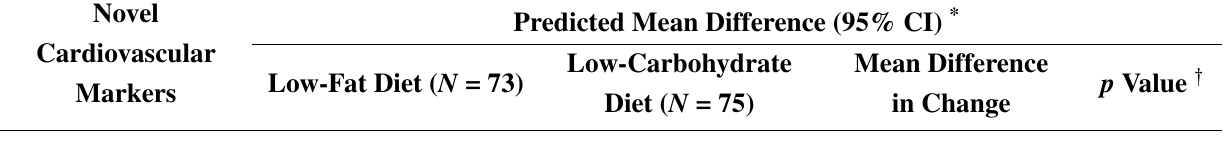
Table A3. Predicted mean difference in changes in novel cardiovascular markers from baseline by assigned dietary group among African-Americans *